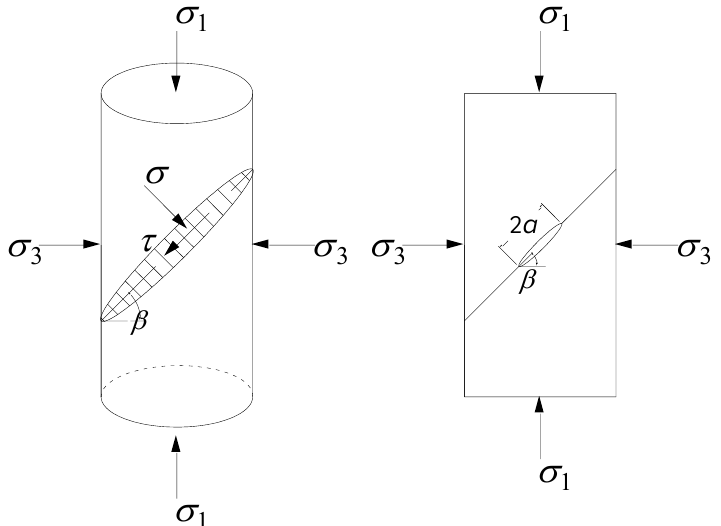
Figure 5. Standard specimen with the inclined throughout joint under triaxial compression.